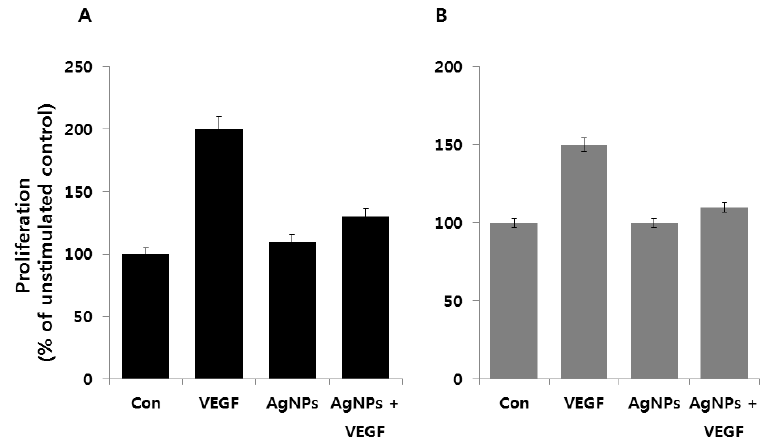
Figure 6. Effect of AgNPs on vascular endothelial growth factor (VEGF)-induced proliferation of ( A ) bovine retinal endothelial cells (BRECs); and ( B ) human breast cancer cells MDA-MB 231. Cells were treated with VEGF with or without AgNPs for 24 h. Cell proliferation was determined by trypan blue exclusion assay.